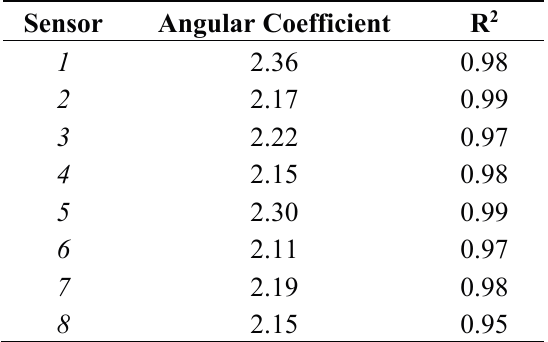
Table 1. Parameters of the linear regressions performed on the EC sensors used in the experiment and evaluated at different EC levels—from 4 mS/cm up to 12 mS/cm, by incremental steps of 2